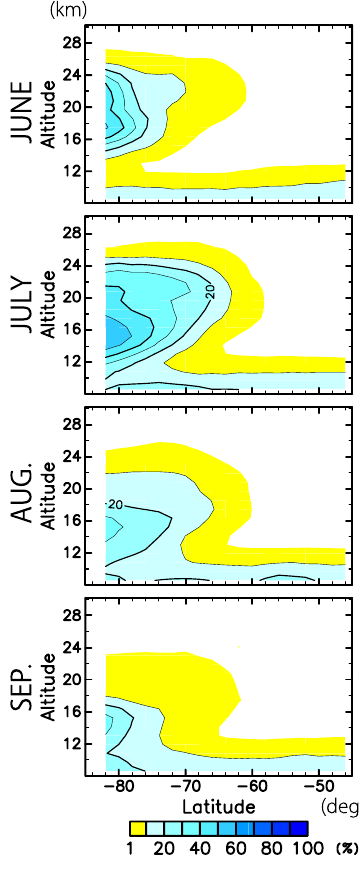
Fig. 2. Latitude-altitude sections of zonal-mean monthly-mean PSC frequency F , in June through September 2008, obtained from CALIPSO